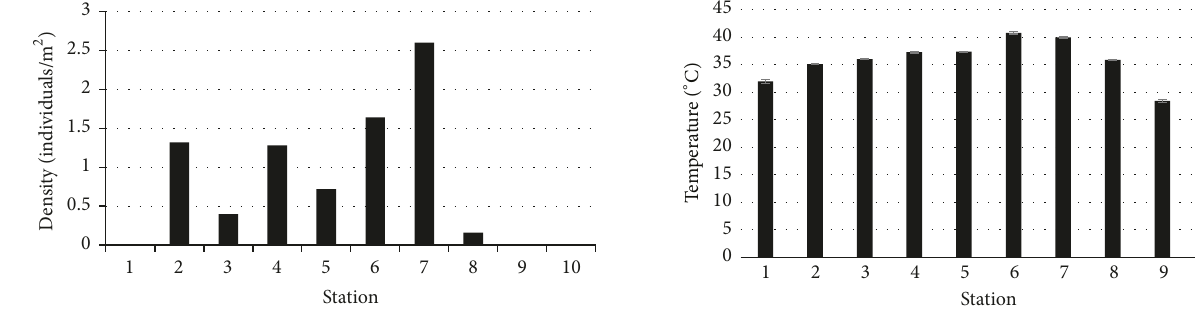
Figure 6: Mean temperature from every station.